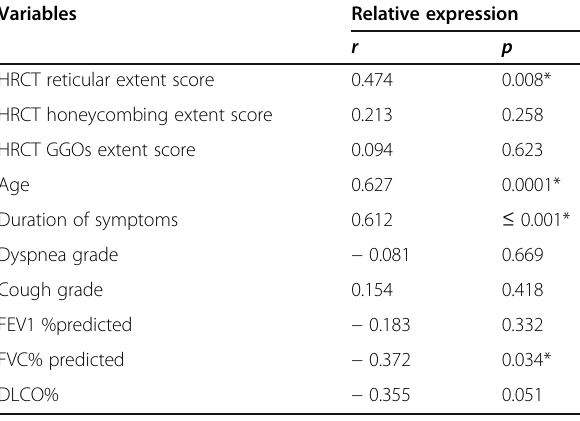
Table 3 Correlation between TERRA expression and different clinical and radiological characteristic Variables Relative